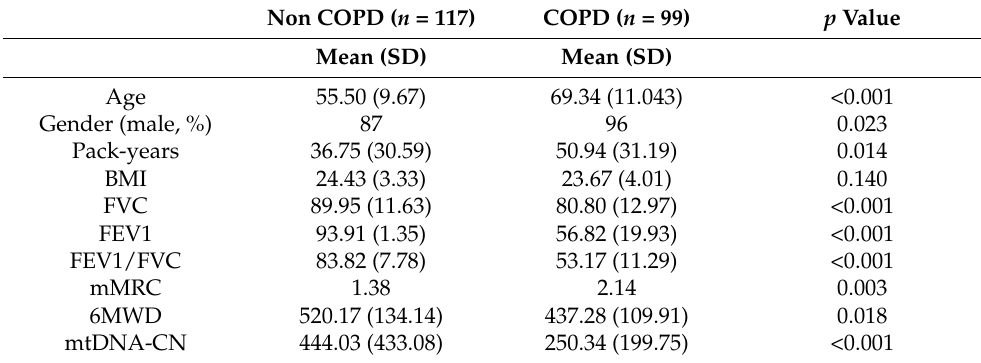
Table 1. Clinical characteristics of COPD group and non-COPD group.